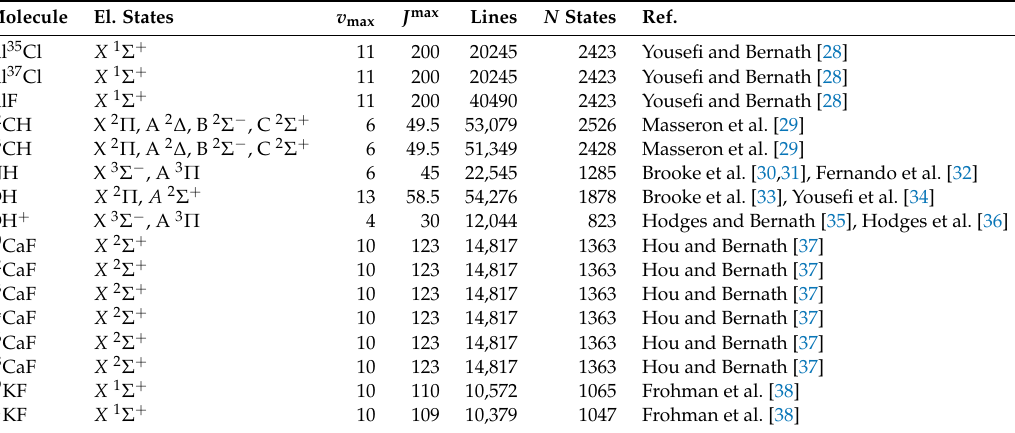
Table 3. Empirical line list included in the ExoMol database. The number of lines and number of states included in each line list are given. The maximal temperatures of the partition functions is T = 5000 K. All MoLLIST empirical line lists are named ‘MoLLIST’. The N 2 line list by Western et al. [21] is called